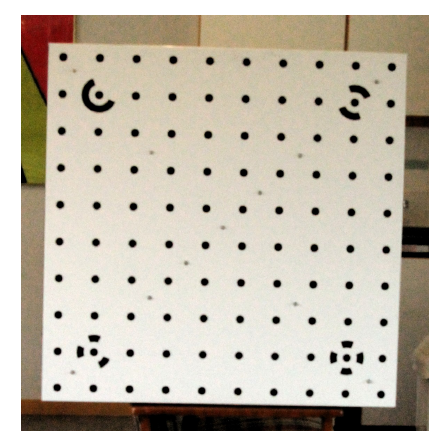
Figure 1: The five-camera rig in the field, carried with Easyrig 2.5.